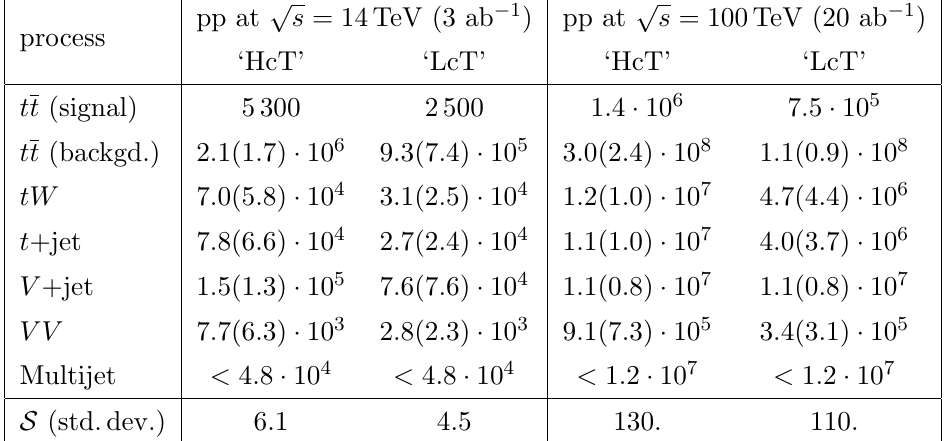
= 2 && N j = 1) indicates the c b